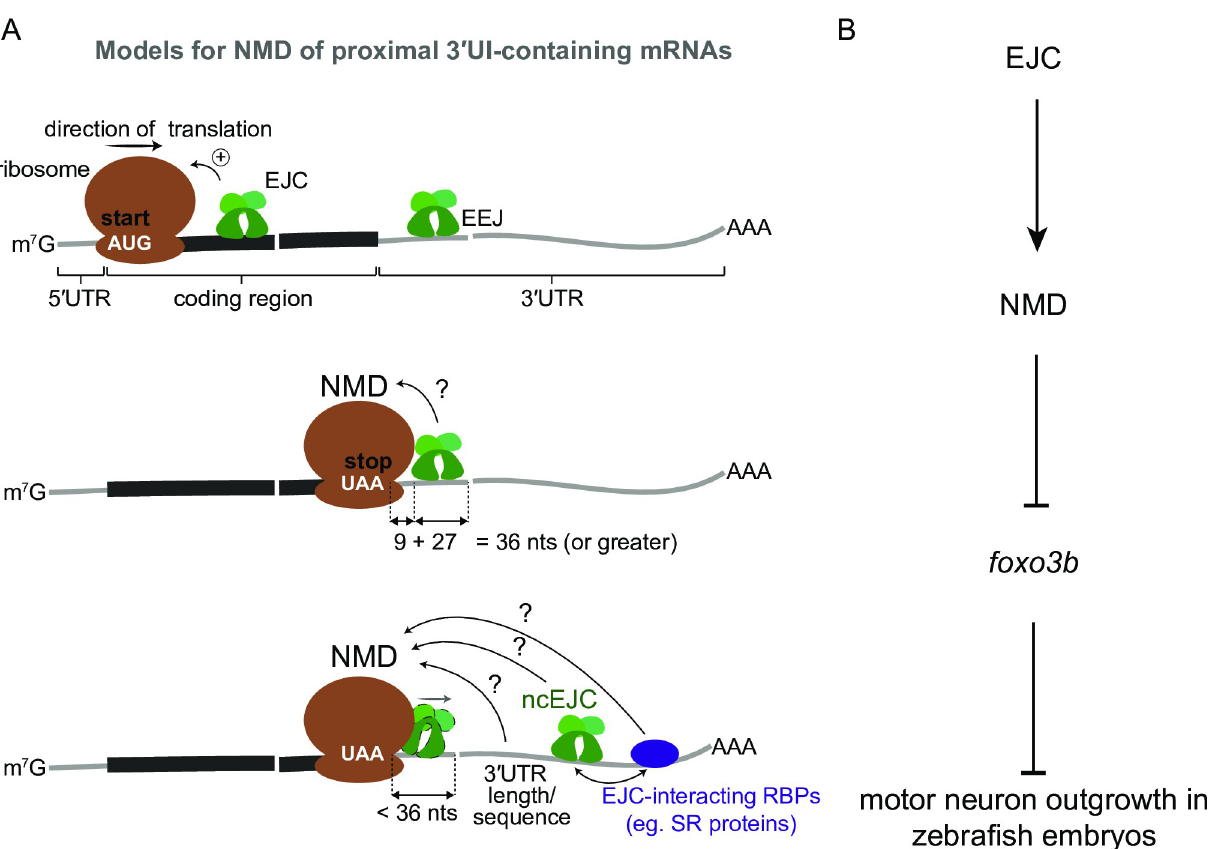
Fig 9. Possible models for EJC-dependent NMD of proximal 3 0 UI-containing transcripts and regulation of foxo3b function in zebrafish motor neurons. A. Top: EJCs can function to enhance NMD via translation stimulation. Ribosome (brown), direction of translation (straight arrow), start codon (‘AUG’ in white), EJC (green), exon-exon junction (EEJ), mRNA coding region (thick black line) and mRNA 5 0 and 3 0 UTRs (thin gray lines) are labeled. Middle: a model for downstream EJC function in NMD of transcripts where the distance between stop codon (‘UAA’ in white) and downstream exon-exon junction is 36 nts or greater to accommodate both the EJC and the ribosome. Bottom: a model for NMD of transcripts where the distance between stop codon and downstream exon-exon junction is less than 36 nts. Displacement of stop codon-proximal EJC by the ribosome is shown. In this case other downstream factors such as a non-canonical EJC (ncEJC), EJC-interacting RBPs (e.g. SR proteins), or 3 0 UTR length and/or specific sequences may be responsible for NMD. B. A schematic depicting a model for EJC- and NMD-dependent regulation of foxo3b as a genetic pathway that is critical for zebrafish motor neuron